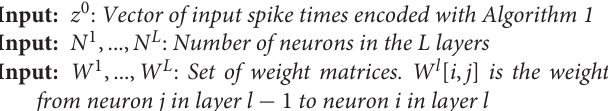
Algorithm 1 : Pseudocode of the forward pass in a feed-forward network with L layers.